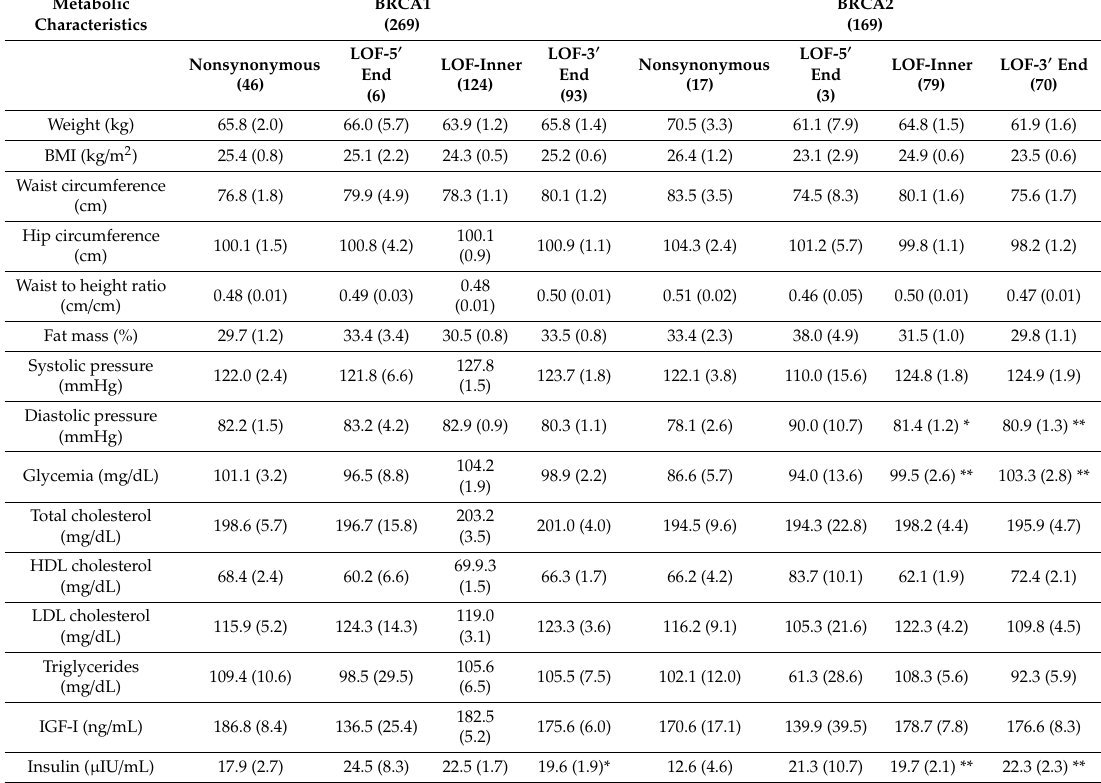
Table 6. Distribution of metabolic characteristics by BRCA variant type and